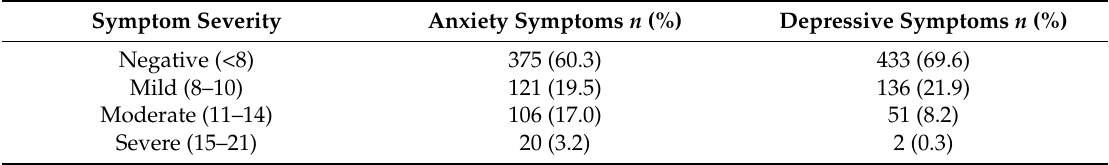
Table 3. Severity of depressive and anxiety symptoms ( n = 622).